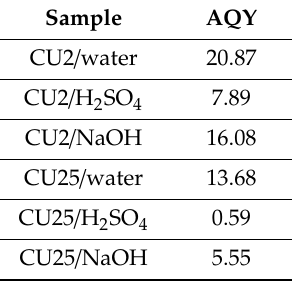
Table 2. Absolute photoluminescence quantum yield (AQY) results of C-dots dispersed in different media.